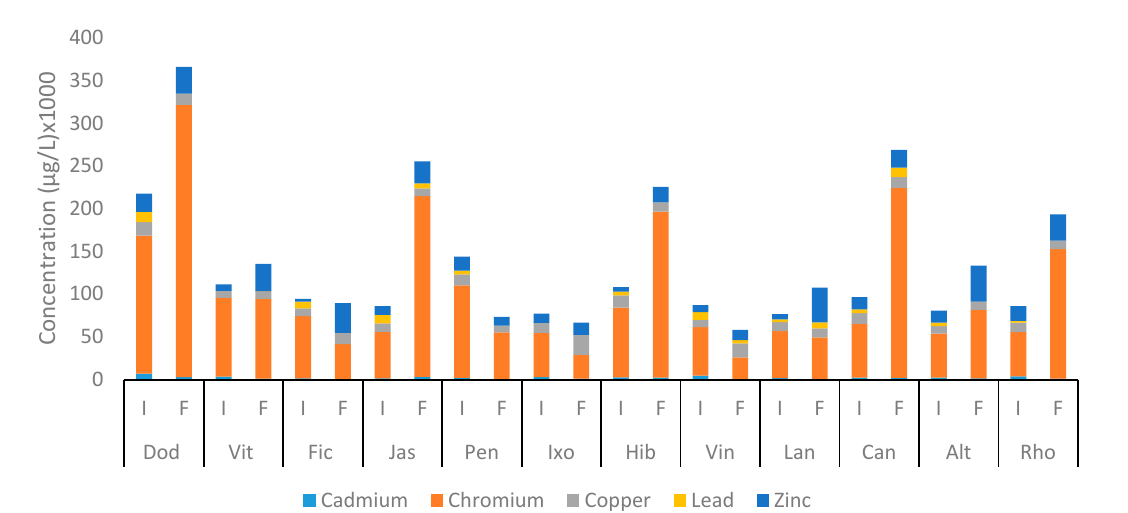
Figure 4. Average concentration of heavy metals in soil samples at the beginning (I, before irrigation with greywater) and at the end (F, after irrigation with greywater) of the experimental period (please see Table S4 for the data).